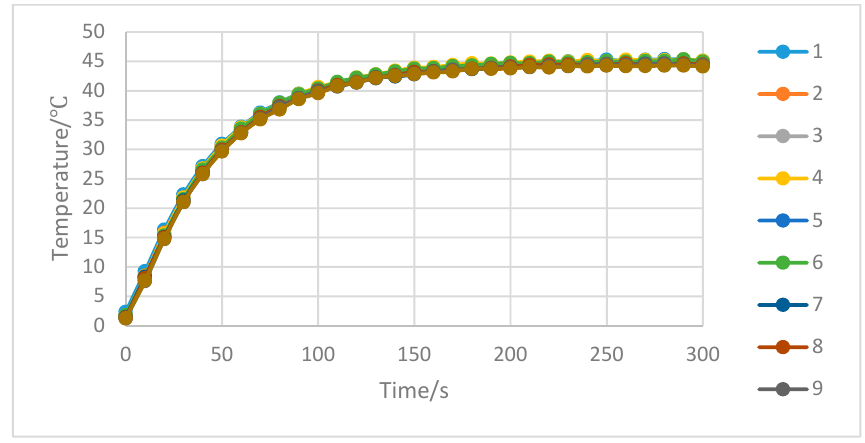
Figure 15. Ten sets of temperature difference curves measured when the input current is 5 A.